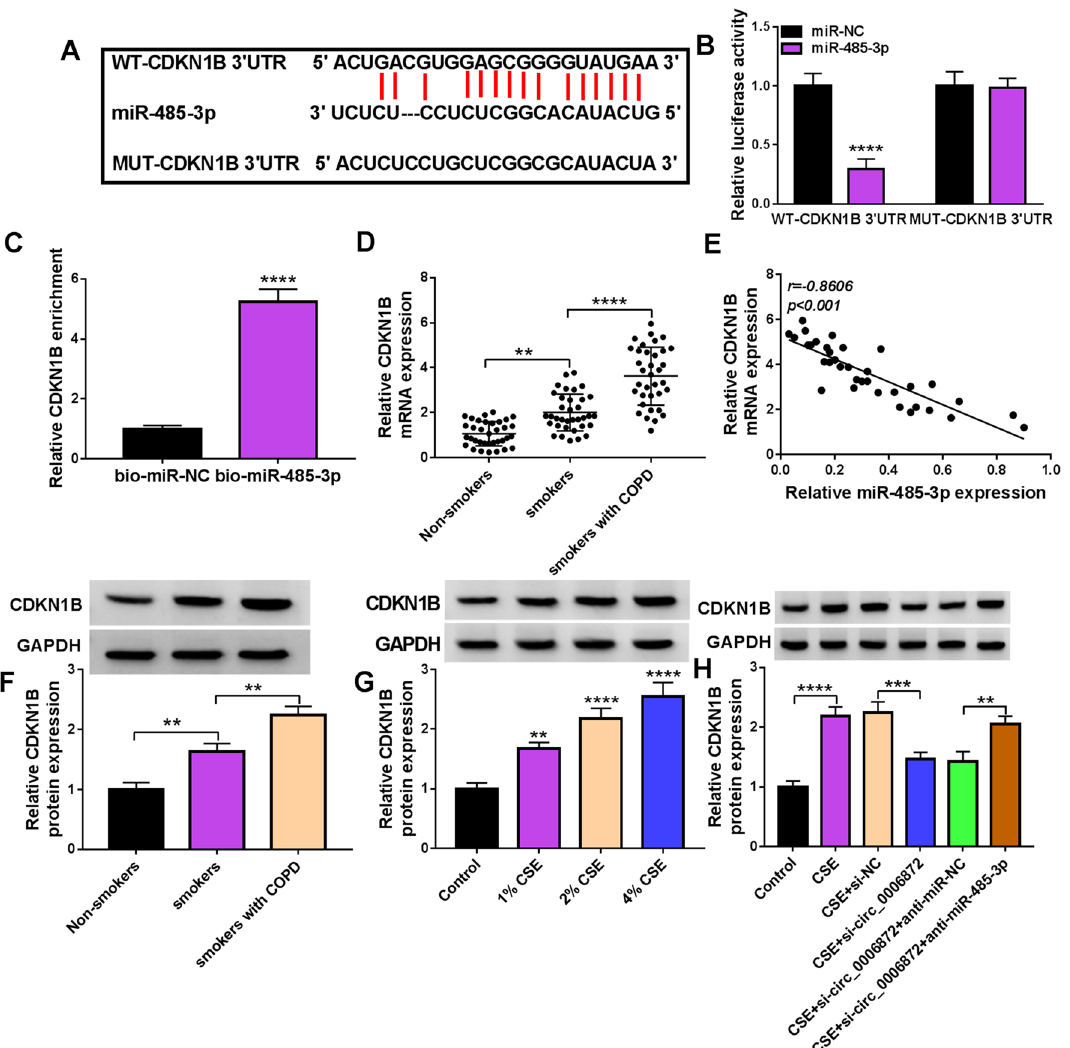
Fig. 5 CDKN1B is a target of miR-485-3p, and circ_0006872/miR-485-3p/CDKN1B constitutes a feedback loop in 16HBECs. A The conserved target site of miR-485-3p on CDKN1B predicted by starbase software was listed. B , C The interaction between miR-485-3p and CDKN1B was confirmed using dual-luciferase reporter assay and RNA pull-down assay. D Levels of CDKN1B mRNA in non-smokers (n with COPD (n 35). E The correlation between miR-485-3p and CDKN1B mRNA expression level in smokers with COPD (n = Pearson’s correlation coefficient assay (r -0.8606, p < 0.001). F CDKN1B protein level in non-smokers (n = COPD (n 35). G CDKN1B expression in 16HBECs exposed to different concentrations of CSE. H The impacts of circ_0006872/miR-485-3p axis on = CDKN1B expression in 16HBECs under CSE treatment. ** P < 0.01, *** P < 0.001, **** P <